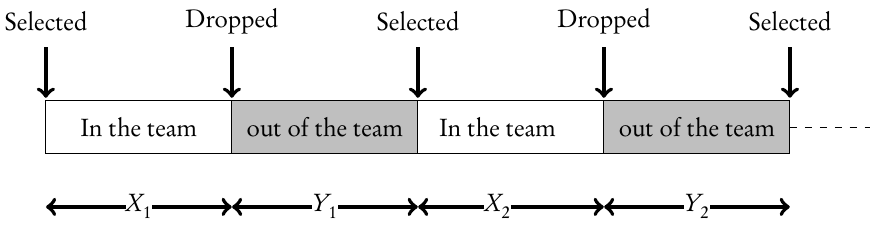
Figure 1 – Showing recurrences of inclusion and exclusion for a particular